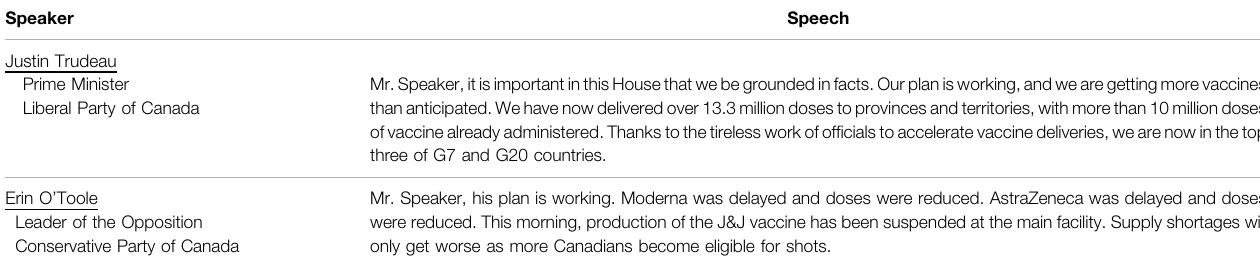
TABLE 1 | An excerpt taken from the Edited Hansard No. 84 for the 2nd Session of the 43rd Parliament held on April 20th ,